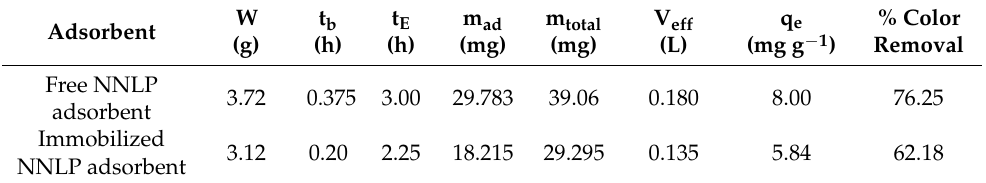
Table 7. Column experimental parameters for the adsorption of solute onto free and sodium silicate gel-immobilized NNLP adsorbents with industrial CR dye